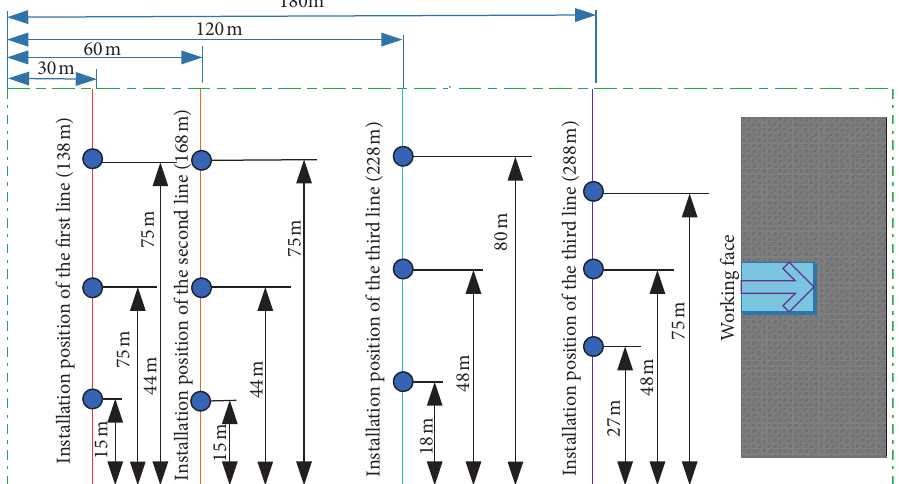
Figure 14: Equipment layout of 2351 rock-like filling face.